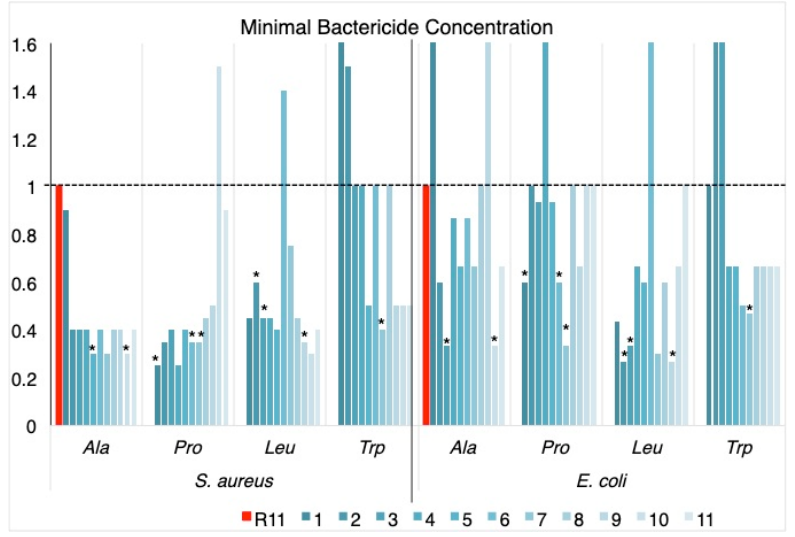
Figure 1. MBC values normalized with respect to R11 (MBC peptide/MBC R11). Replacements are shown in color gradient, from dark to light blue for positions 1 to 11, for each amino acid scanning. Black line denotes R11 value (red bars); asterisks (*) indicate the selected peptides with the lowest MBC against the two bacteria (Table 1).